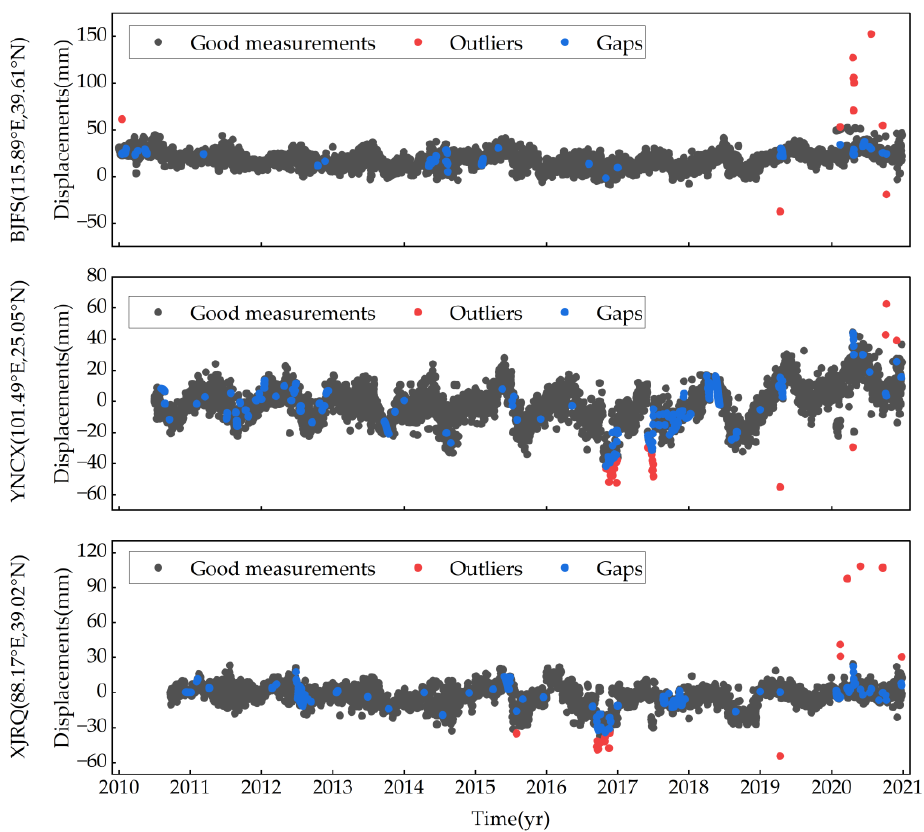
Figure 4. The vertical time series before and after conducting the pre-processing procedure of three typical GPS sites (BJFS: 115.89°E, 39.61°N, YNCX: 101.49°E, 25.05°N and XJRQ: 88.17°E, 39.02°N) are shown. Good measurements (black points) plus outliers (red points) present the raw time series. Good measurements (black points) plus gaps (blue points) present the input time series to our in- vestigations.